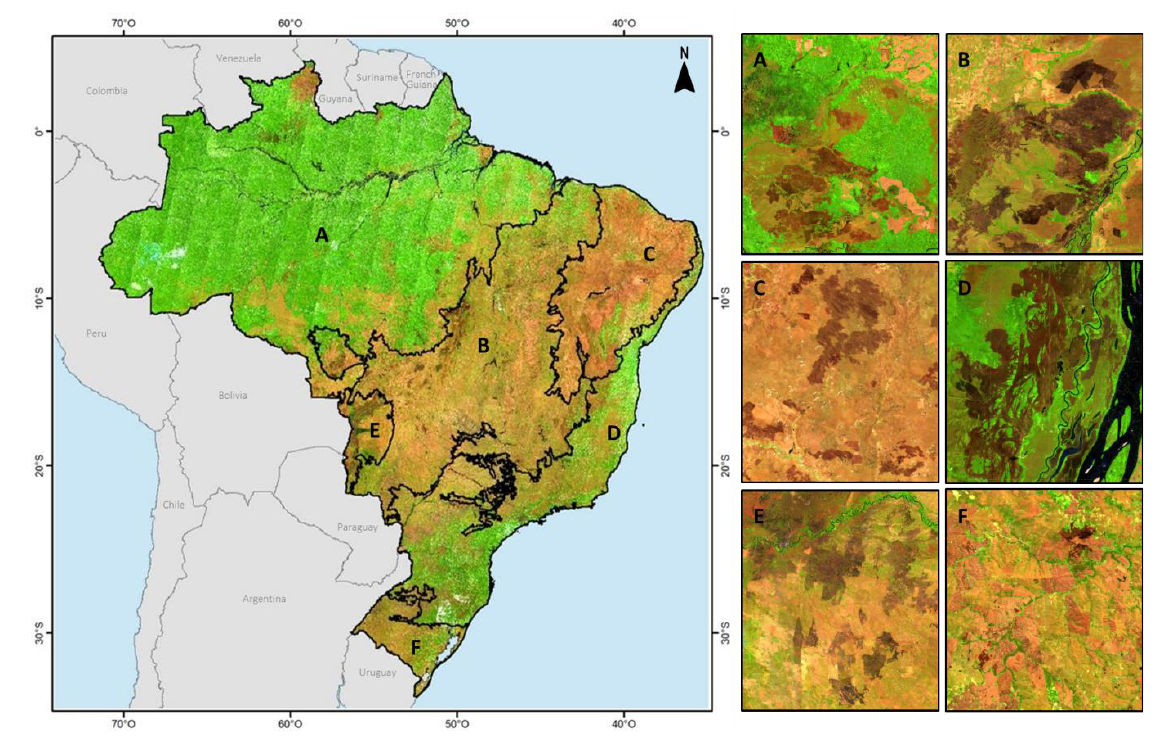
Figure 3. The 2020 quality mosaic (QM) for Brazil (RGB SWIR-1, NIR, RED), created from spectral information retrieved from the minimum NBR pixels in a year, showing examples of the diversity of burn scars by biome: ( A ) Amazon, ( B ) Cerrado, ( C ) Caatinga, ( D ) Atlantic Forest, ( E ) Pantanal, and ( F ) Pampa.